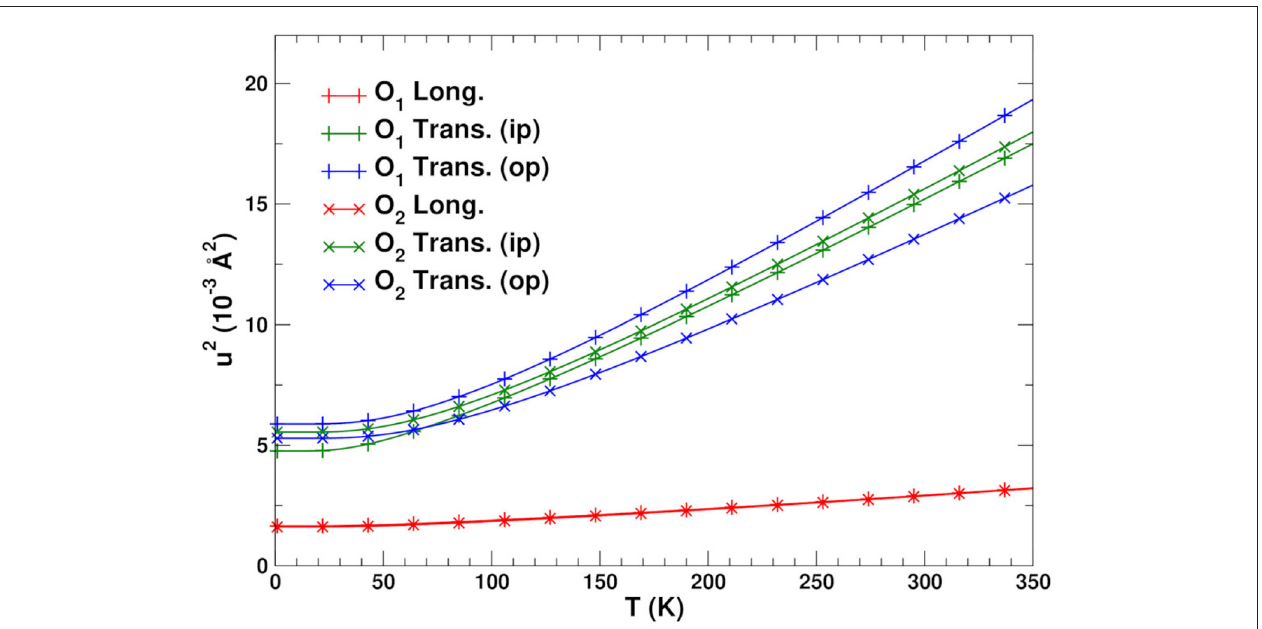
FIGURE 5 | Longitudinal and transverse MSDs u 2 for the O1 and O2 bridging